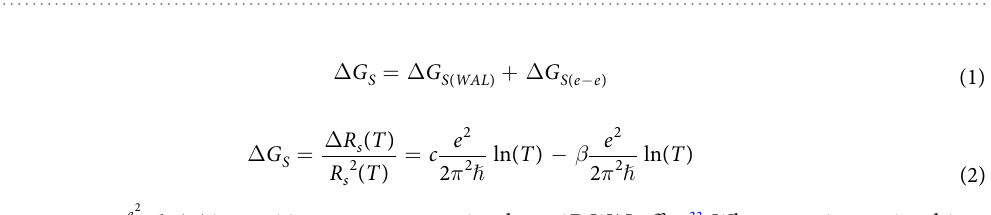
negative correction in the conductance is given as;